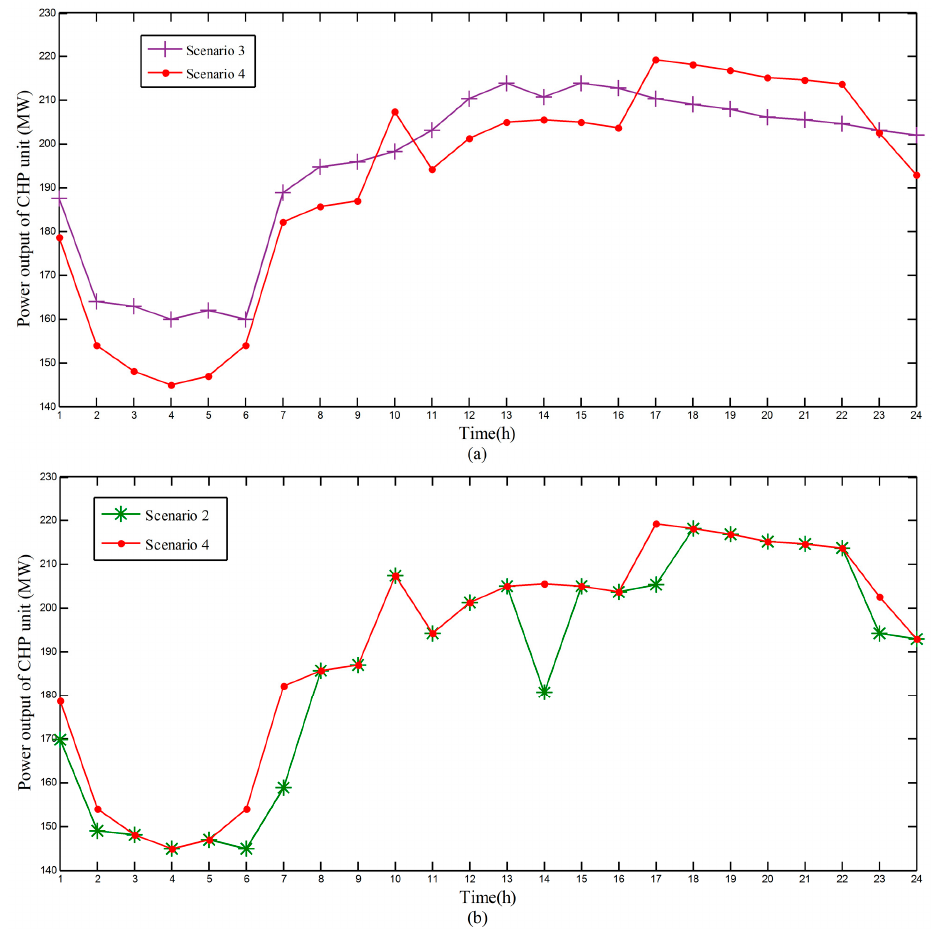
Figure 10. The comparisons of the power outputs of CHP in ( a ) Scenario 3 and 4 and ( b ) Scenario 2 Figure and 4.